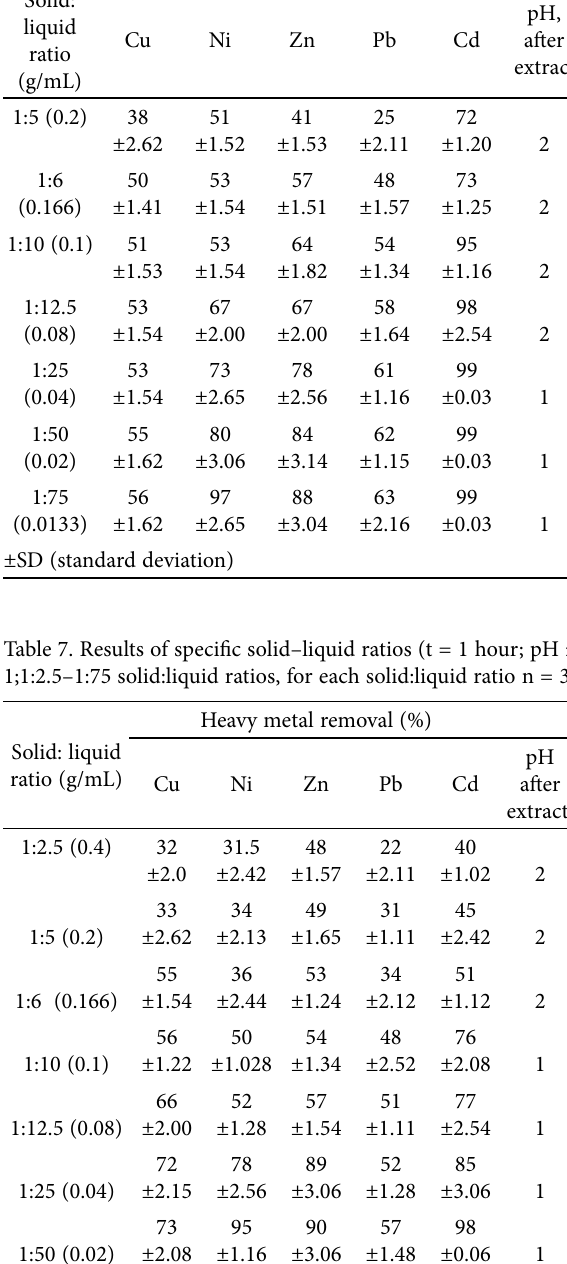
Table 6. Results of specific solid–liquid ratios (t = 30 minutes; pH ≤ 1; 1:5–1:75 solid:liquid ratios, for each solid:liquid ratio n = 3) Heavy metal removal (%)